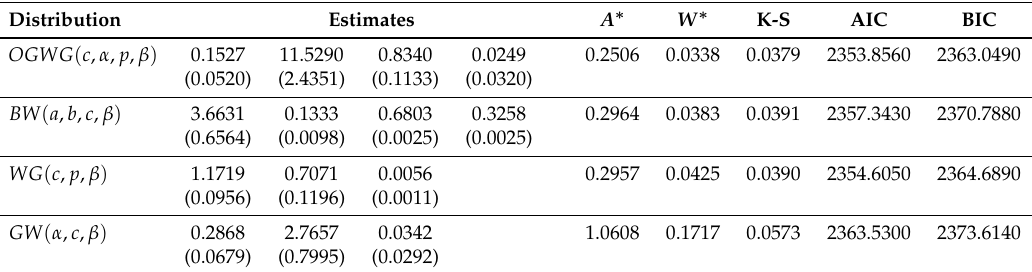
Table 4. MLEs, their SEs (in parentheses) and goodness-of-fit measures for data set 1.